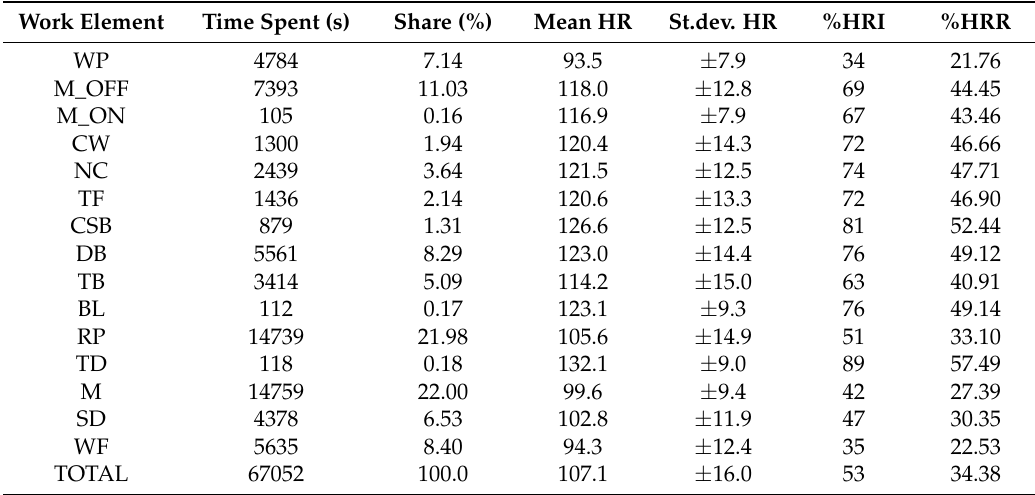
Table 4. Breakdown of the cardiovascular activity and of the experienced work